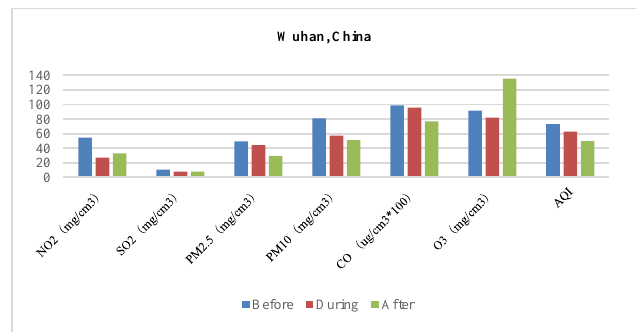
Figure 4: Mean and standard deviation for three month duration before, during and post COVID-19 period for NO 2 , SO 2 , PM 2.5 , PM 10 , CO, and O 3 in Wuhan, China.